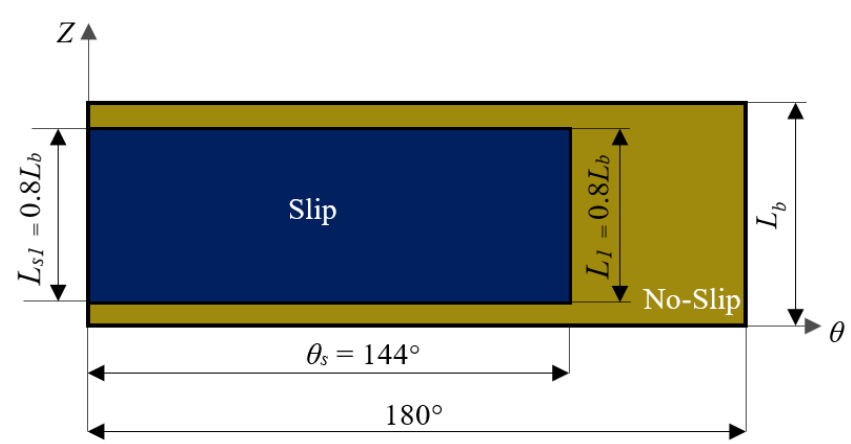
Figure 2. Configuration of heterogeneous slip/no-slip on stationary surface.